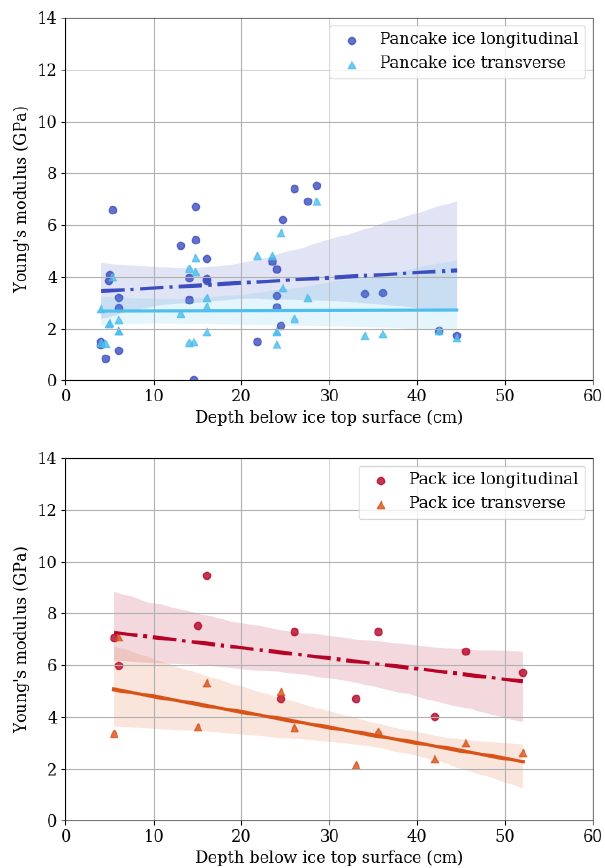
Figure 12. Longitudinal and transverse Young’s modulus for pan- cake ice cores M01-US-01-A, M01-US-01-B, M01-US-01-C, M01- US-01-D, M01-US-02-A, M01-US-02-B, M01-US-02-C and M01- US-02-D as well as consolidated pack ice cores M03-US-01-A and M03-US-02-A as a function of depth from the top of the ice. The shading indicates the 90th-percentile confidence intervals. direction ( r = − 0 . 597, n = 11, p = 0 . 053) and in the trans- verse direction ( r = − 0 . 741, n = 11, p = 0 . 009). A